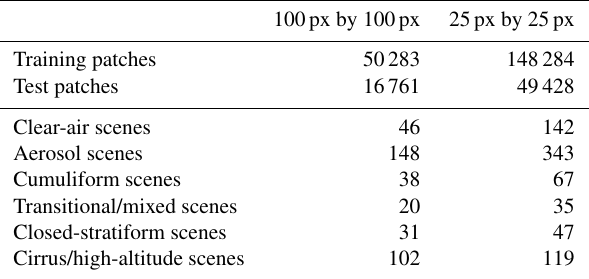
Table 3. The first two rows show the number of patches in the train- ing and test datasets per patch size. The rest of the rows show the number of unique MODIS–VIIRS image subsets from which the patches were